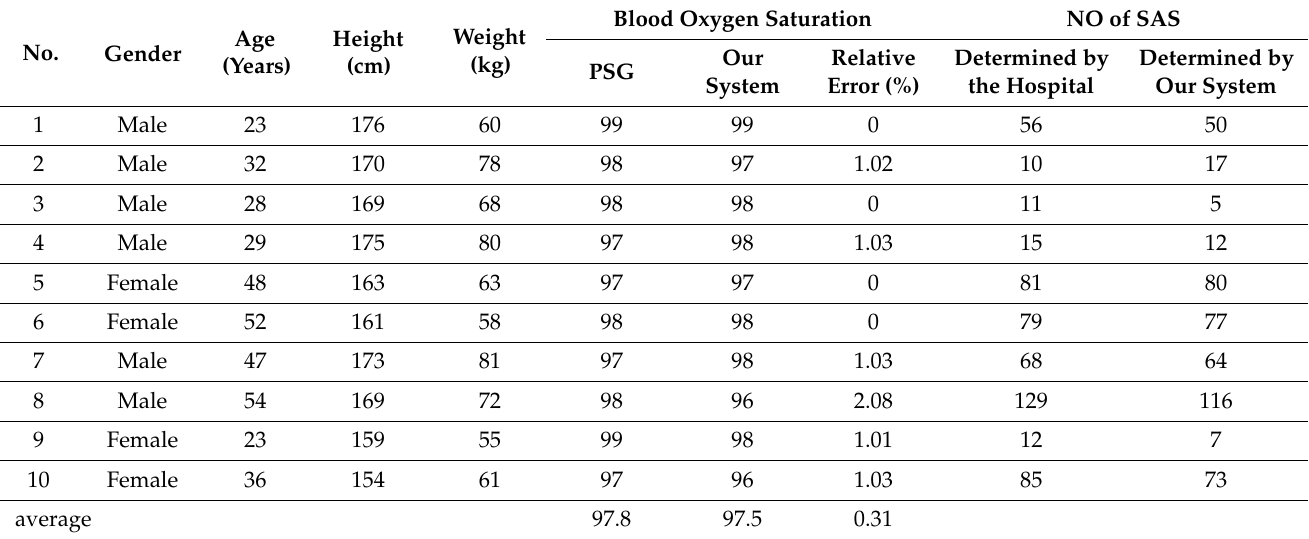
Table 3. Basic information on 10 subjects.